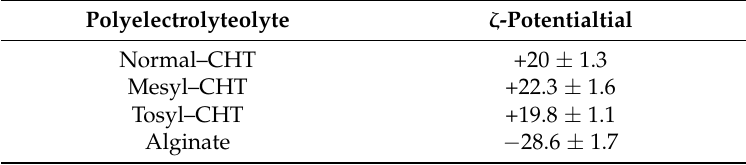
Table 1. ζ -Potential values of CHT (0.1%) and ALG (0.1%) in aqueous solution with 0.15 M NaCl (pH =